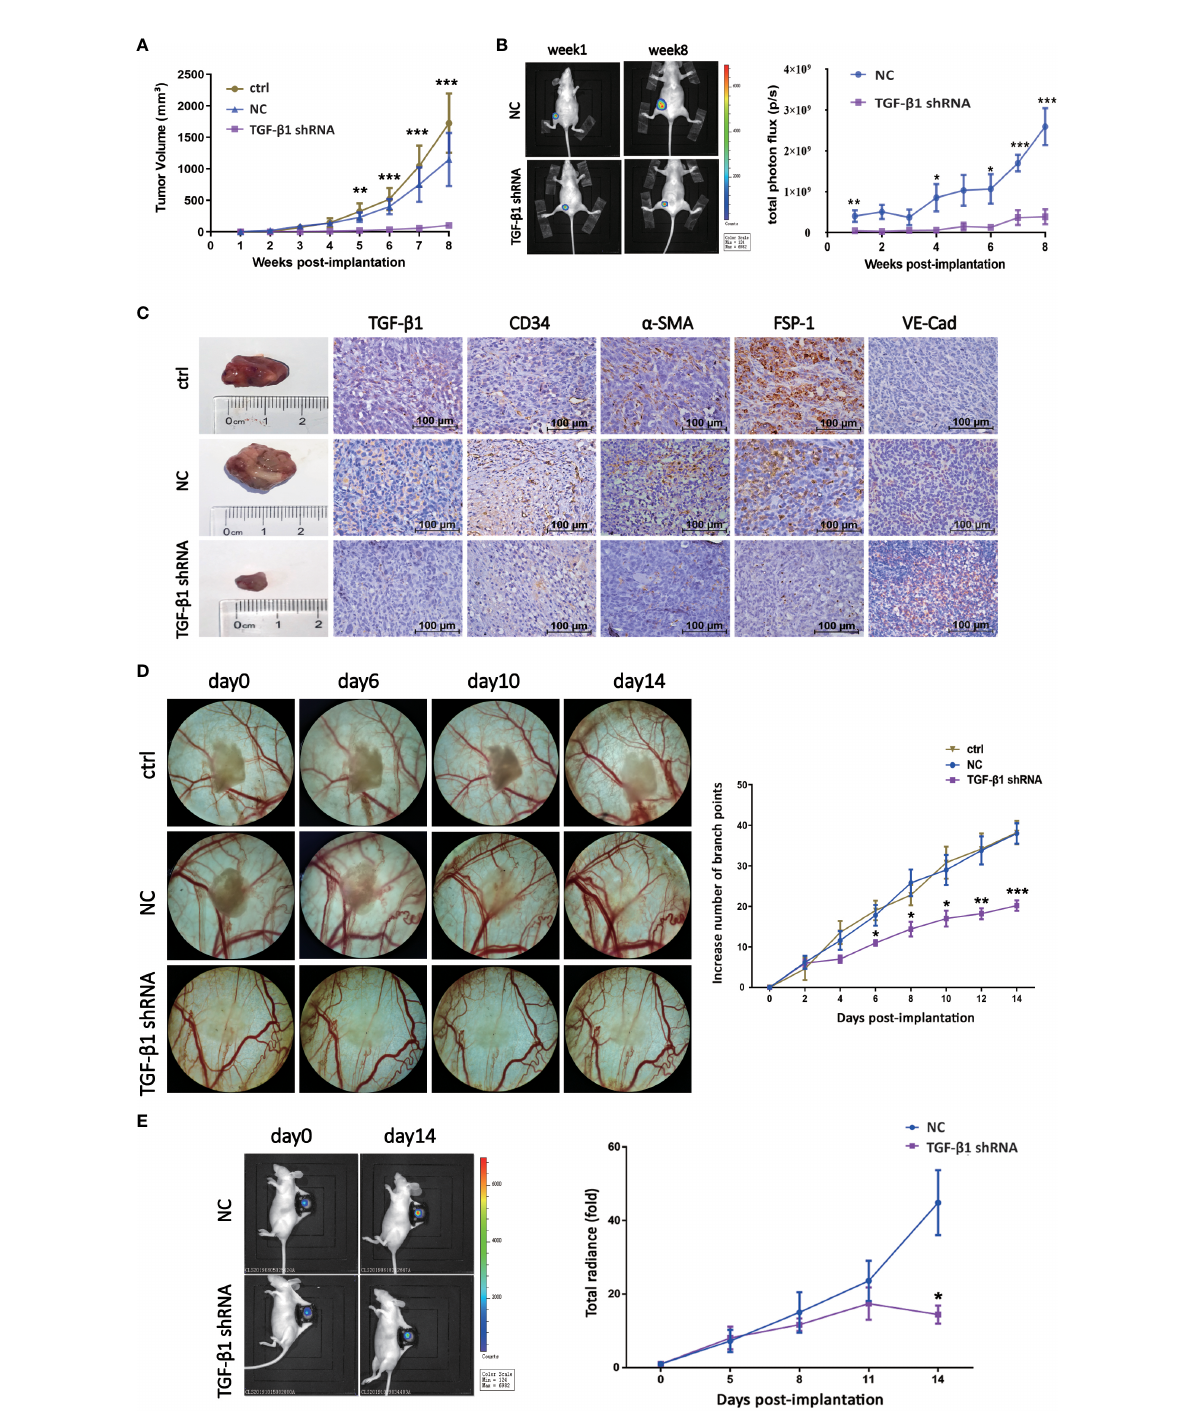
FIGURE 5 TGF- b 1 promoted tumor growth and angiogenesis of breast cancer in vivo . (A) Quantitative analysis of tumor volume of xenografts. Tumor volume was compared at indicated time points. **p < 0.01 and ***p < 0.001 versus ctrl group. (B) Representative pictures of luciferase imaging and quantitative analysis of total photon fl ux of xenografts. Total photon fl ux was compared at indicated time points. *p < 0.05, **p < 0.01 and *p < 0.001 versus NC group. (C) Representative images of xenografts and IHC staining for TGF- b 1, CD34, a -SMA, FSP-1 and VE-Cadherin were shown. (D) Representative images of blood vessels of DSWC model and quantitative analysis of branch points. Branch point was compared at indicated time points. *p < 0.05, **p < 0.01 and *p < 0.001 versus ctrl group. (E) Representative pictures of luciferase imaging and quantitative analysis of total photon fl ux of xenografts. Total photon fl ux was compared at indicated time points. *p < 0.05 versus NC group. Means ± SD were